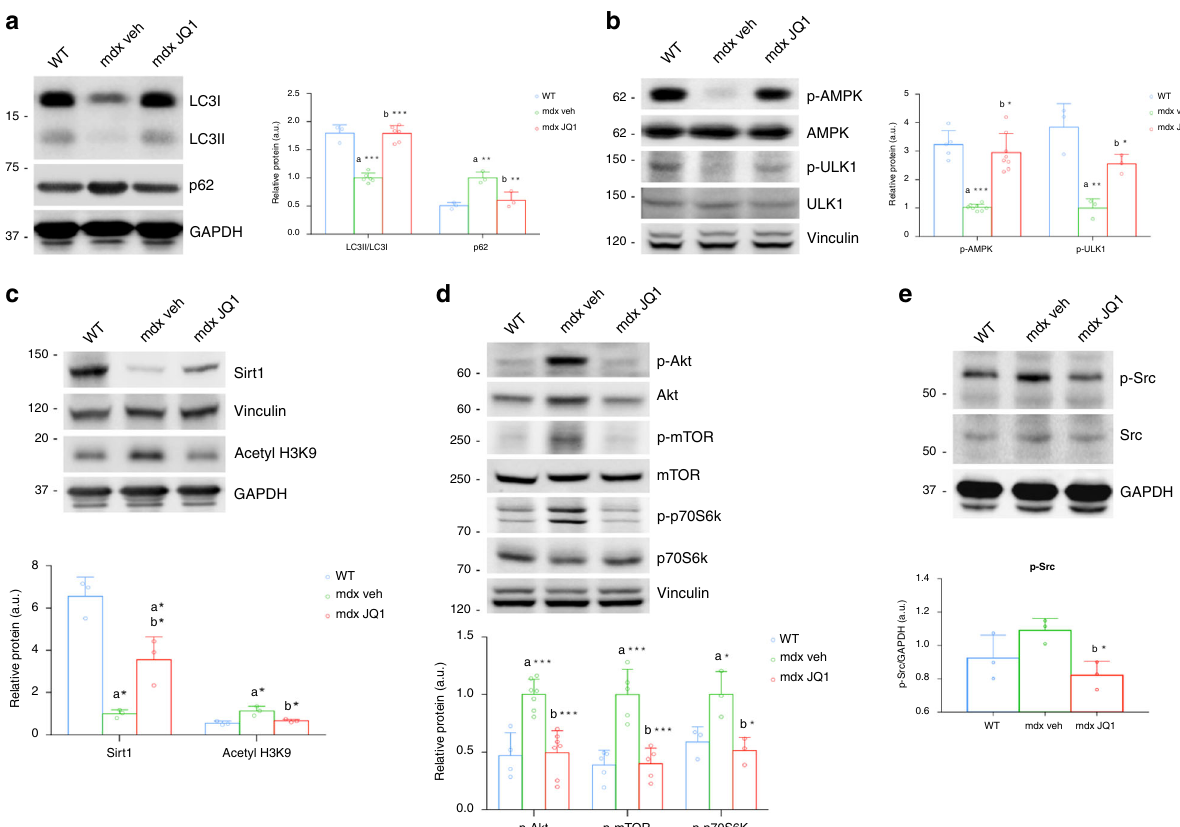
Fig. 3 BET blockade rescues autophagy in the mdx muscle. a Representative western blot for LC3 (WT, n = 3; mdx, n = 6; mdx + JQ1, n = 6) and p62 ( n = 3 for each experimental group) in TA extracts of control and vehicle-and JQ1-treated mice Lower panel: quanti fi cation of normalized band intensity. Data represent means± SD. GAPDH serves as a loading control. b Representative western blot for AMPK and p-AMPK (WT, n = 5; mdx, n = 8; mdx + JQ1, n = 8), Ulk1 and p-Ulk1 (Ser555) ( n = 3 for each experimental group) in TA extracts of control and vehicle-and JQ1-treated mice. Lower panel: quanti fi cation of normalized band intensity. Data represent means ± SD. Vinculin serves as a loading control. c Representative western blot for Sirt1 and H3K9Ac in TA extracts of control and vehicle-and JQ1-treated mice. GAPDH and Vinculin serve as loading controls. Lower panel: quanti fi cation of normalized band intensity. Data represent means ± SD. n = 3 animals per group. d Representative western blot for Akt and p-Akt (Ser473) (WT, n = 4; mdx, n = 7; mdx + JQ1, n = 7), mTOR and p-mTOR (Ser2448) ( n = 5 for each experimental group), p70S6K and p-70SK6 (Thr389) ( n = 3 for each experimental group) in TA extracts of control and vehicle-and JQ1-treated mice Right panel: quanti fi cation of normalized band intensity. Data represent means ± SD. Vinculin serves as a loading control. e Representative western blot for Src and p-Src in TA extracts of control and vehicle-and JQ1-treated mice Lower panel: quanti fi cation of normalized band intensity. GAPDH serves as a loading control. Data represent means ± SD. n = 3 per experimental group. In all panels, statistical analysis was performed by using one-way ANOVA followed by Tukey ’ s post hoc test. In all relevant panels, * P < 0.05; ** P < 0.01; *** P < 0.001. a indicates statistical signi fi cance compared to control; b indicates statistical signi fi cance compared to